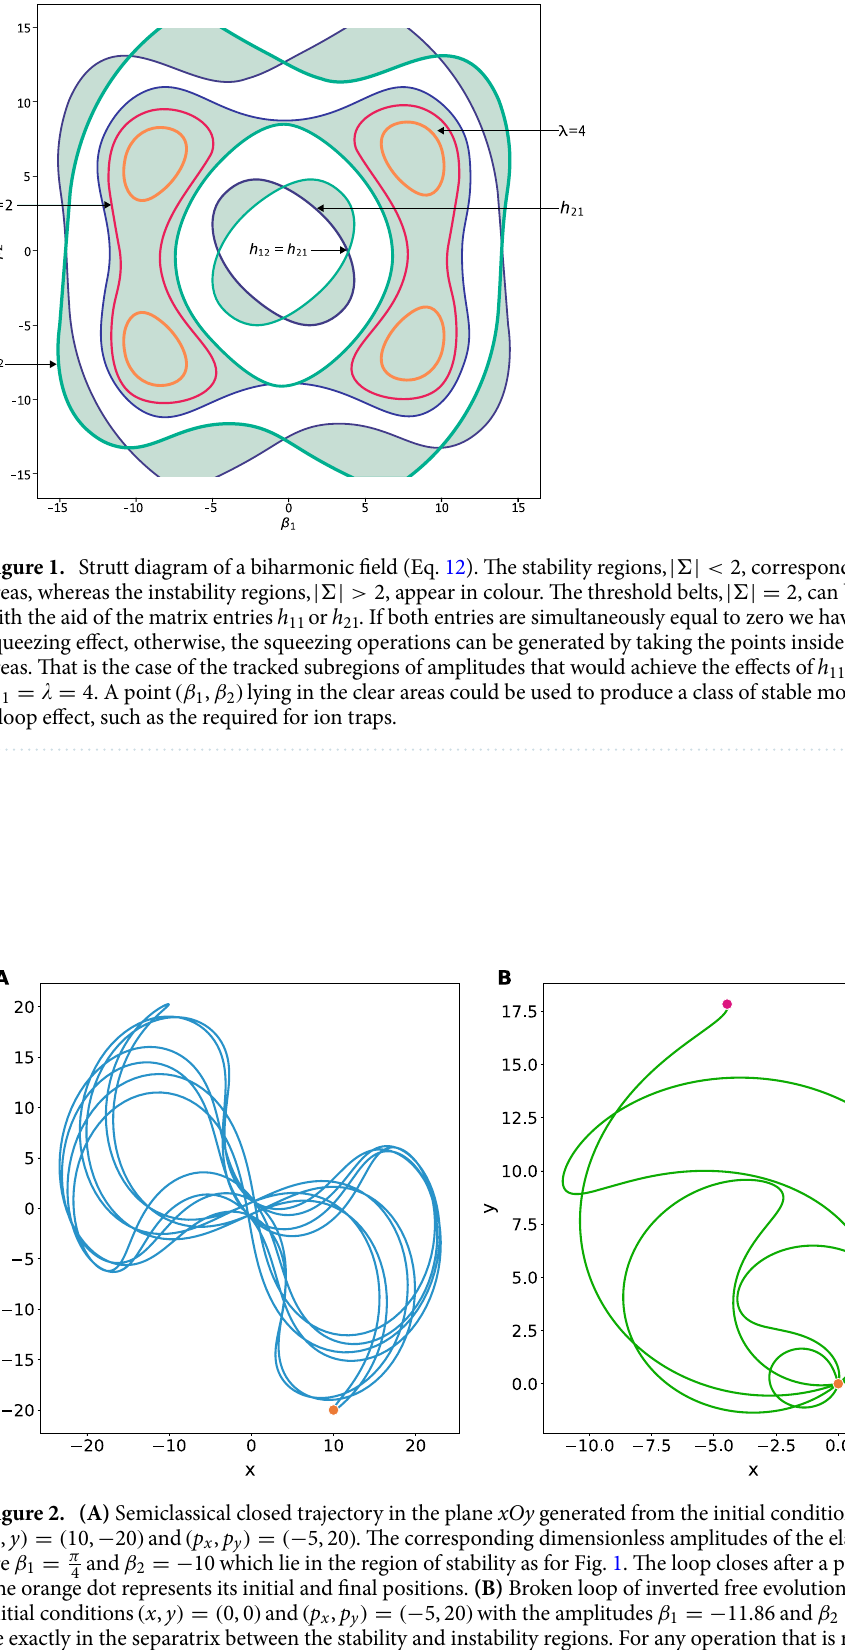
6 . = 11.86 and β 2 0.4 which = − = −